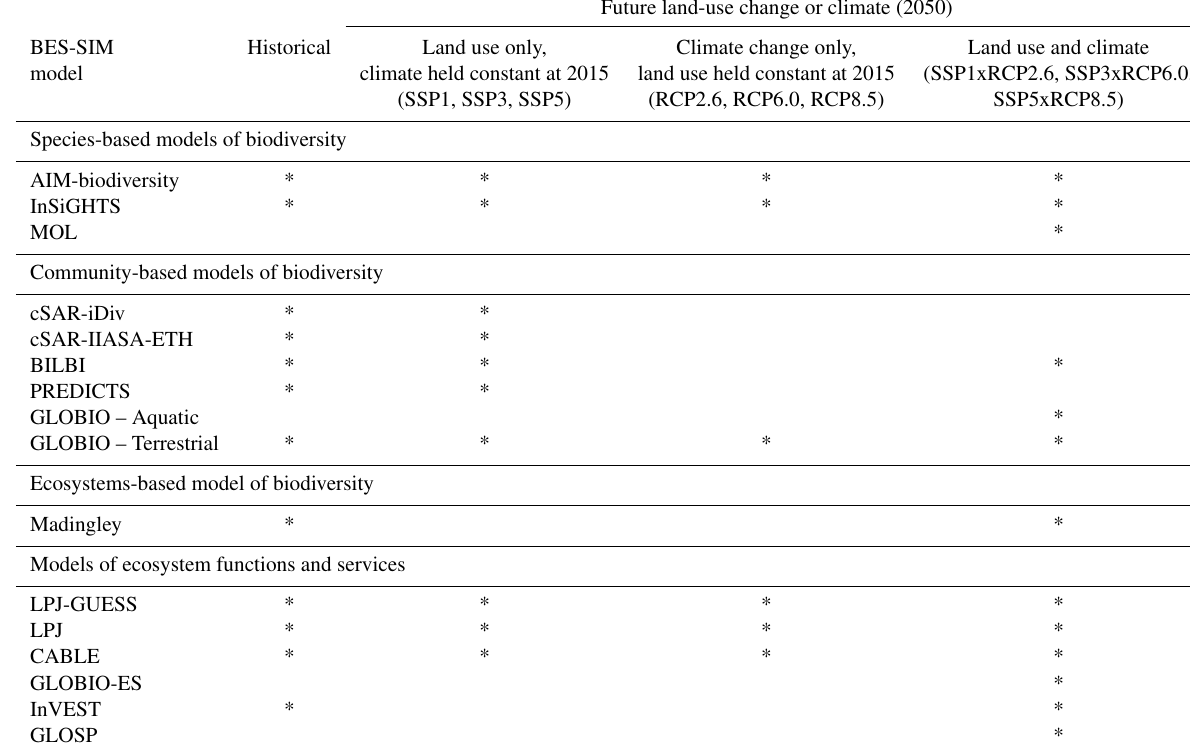
Table 5. Scenario (forcing data) for models in